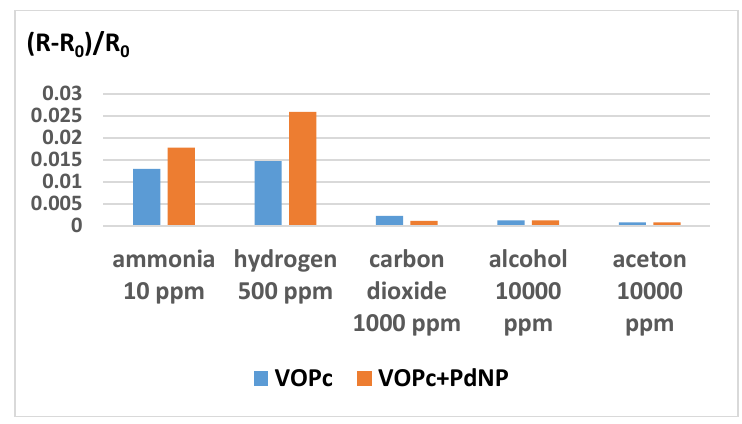
Figure 10. Sensitivity of both VOPc + Pd-NP structures and VOPc films to ammonia, hydrogen, carbon dioxide, alcohol and acetone.